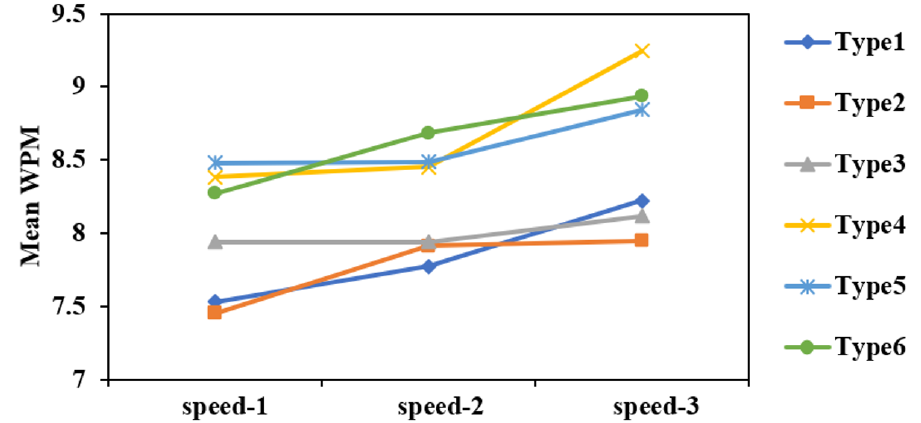
Figure 12. The trend of the entry speed for 6 different placement modes. WPM—words per minute. Error